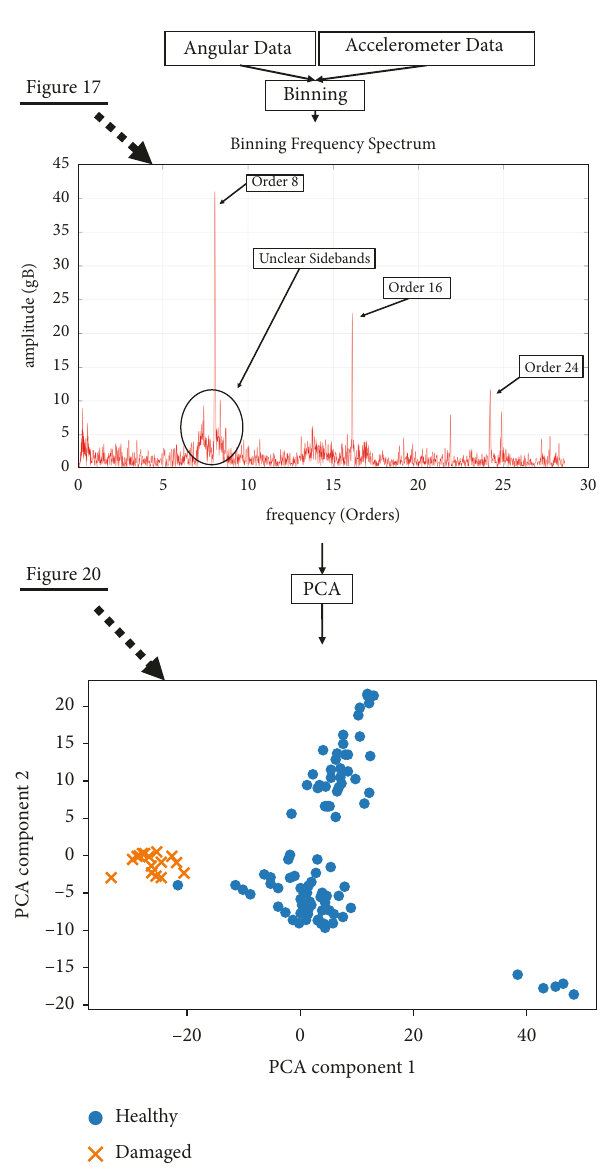
Figure 14: Binning noncyclostationary without damage.